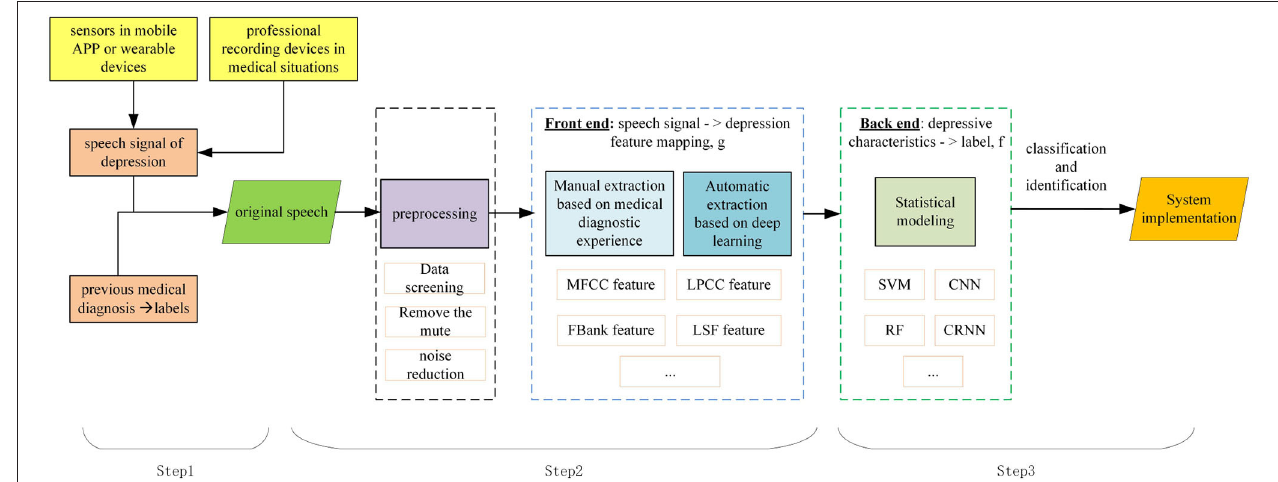
FIGURE 1 | Depression detection based on speech